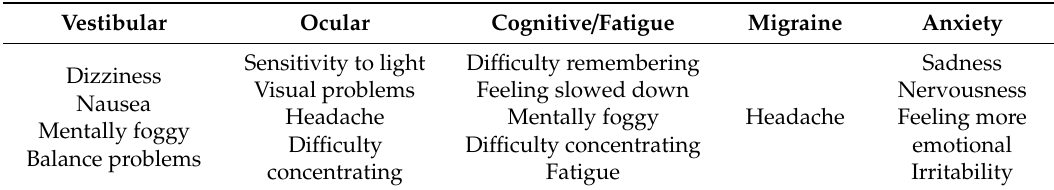
Table 1. Classification of Symptom Profiles